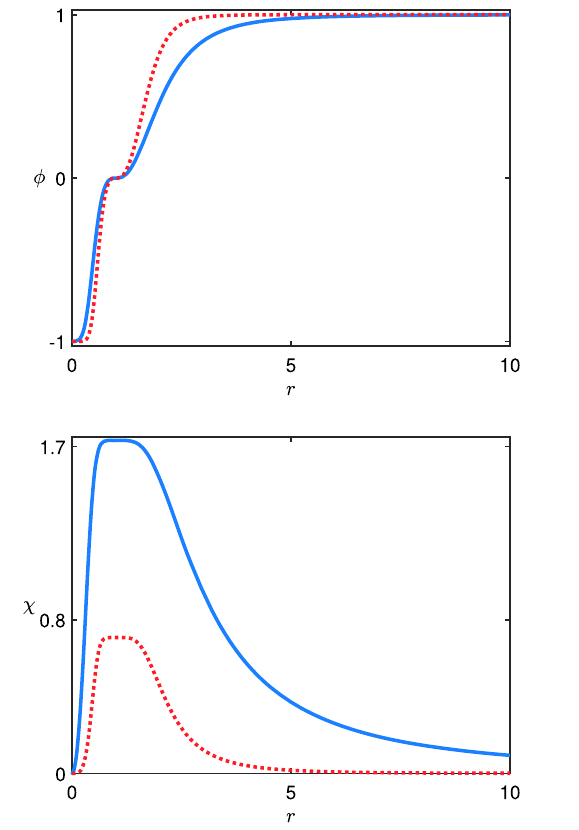
Fig. 8 The solutions φ( r ) (top) and χ( r ) (bottom) associated to the model in Sect. 4.1.1 for σ = 5 and α = 2, with k = 1 (solid, blue line) and 2 (dotted, red line)